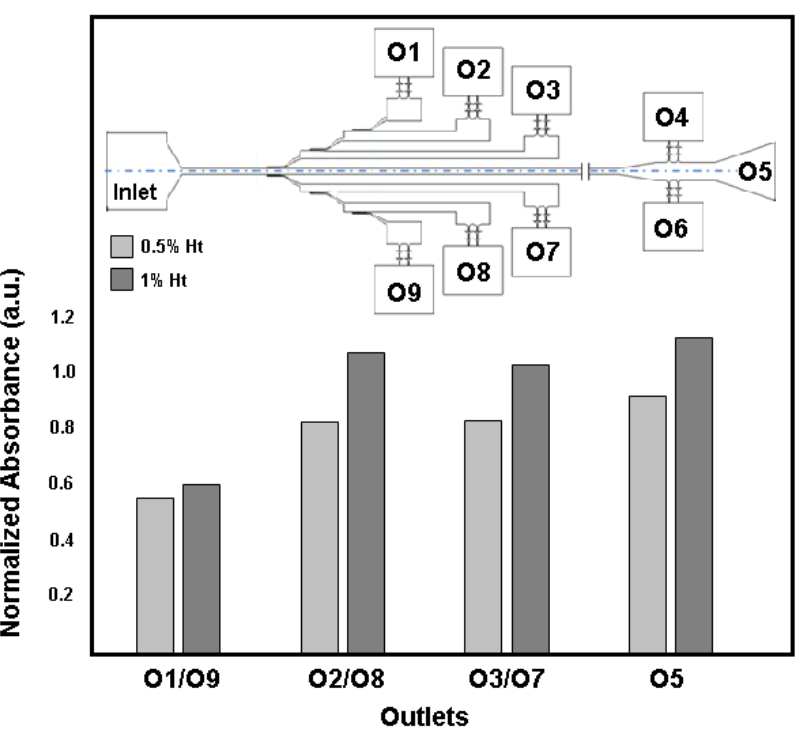
Figure 8. Normalized absorbance spectrum (a.u.) at 412 nm of the samples in the inlet and collected from the outlets of the microchannel using 0.5% Ht and 1% Ht